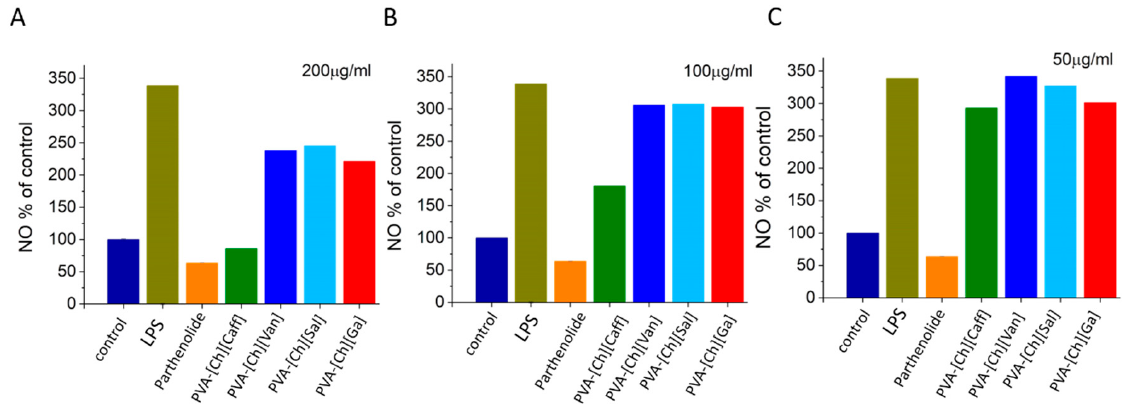
Figure 5. Evaluation of the capacity of iongels to prevent LPS-induced NO production in murine peritoneal macrophages different concentrations (200 µ g/mL ( A ) 100 µ g/mL ( B ) and 50 µ g/mL ( C )) of each polyphenol iongel reported as NO% of control.